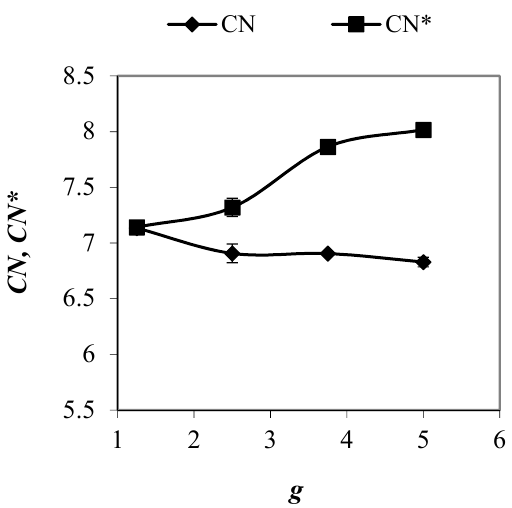
Figure 4. The average coordination number and the mechanical coordination number in mixtures with PSD uniform by number of spheres and various values of g when subjected to a vertical load of 100 kPa.